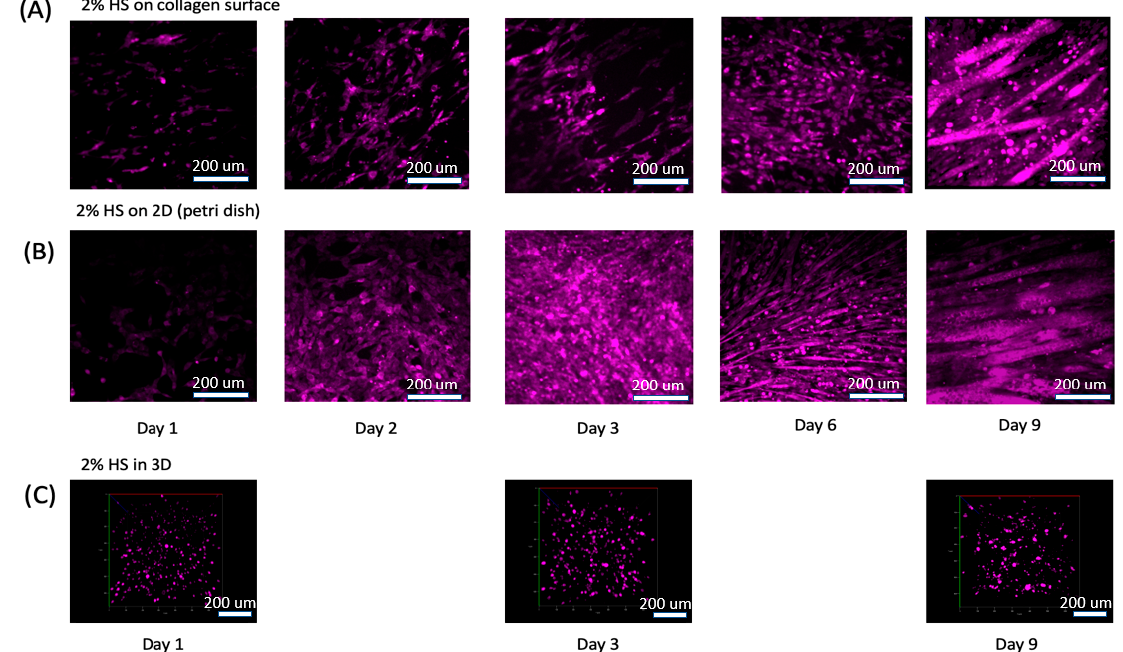
Figure 4. C2C12 were stained with CellTracker DeepRed and treated with DMEM+2%HS for up to 9 days. ( A ) C2C12s cultured on 2.5D collagen surface. ( B ) C2C12s cultured in a petri dish. ( C ) C2C12s cultured in our 3D ECM. See Video S2–S4 for 3D rotational view of the cells.